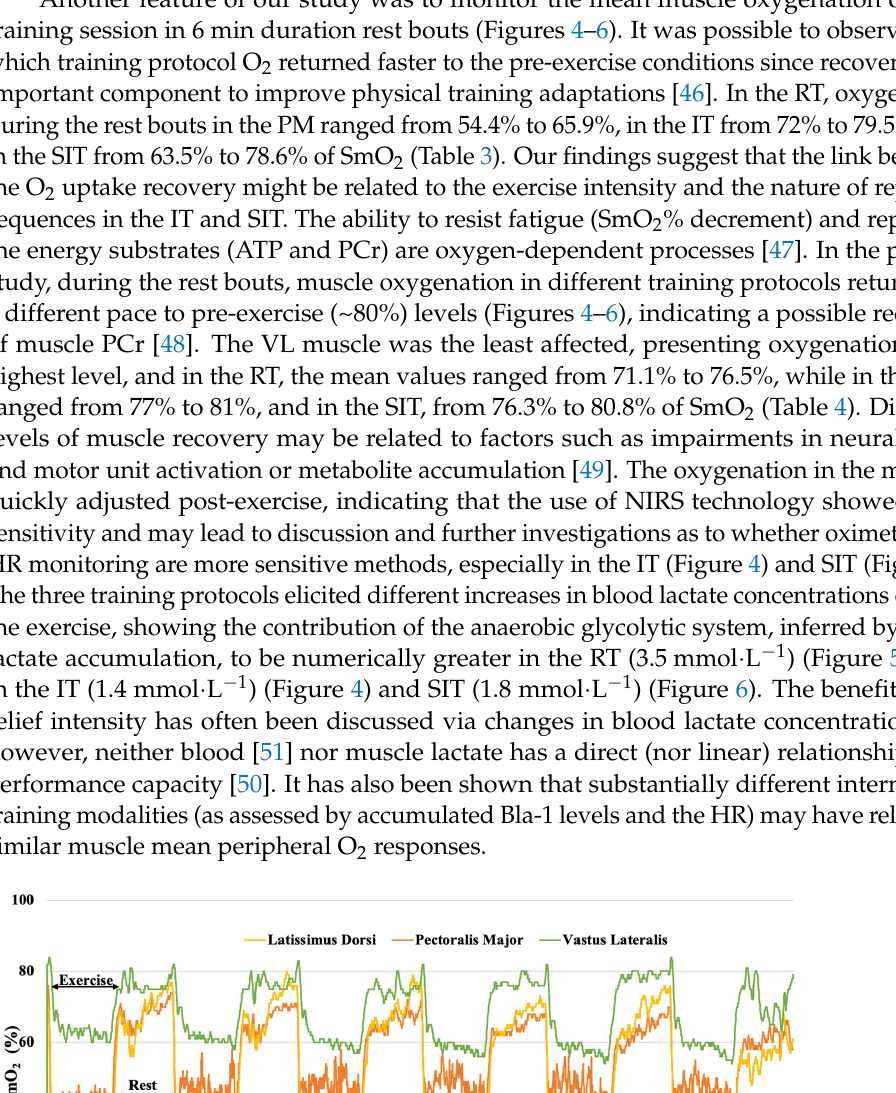
Figure 6. Muscle oxygen saturation (SmO 2 ) kinetics in latissimus dorsi, pectoralis major, and vastus lateralis and heart rate (HR) response during SIT protocol; blood lactate (Bla) concentration 3 min after the end of the protocol. 4.2. O 2 Responses in Different Muscles Information about simultaneous oxygenation in different muscles provides a poten- tial understanding of internal load. Paquette and Bieuzen [30] aimed to understand